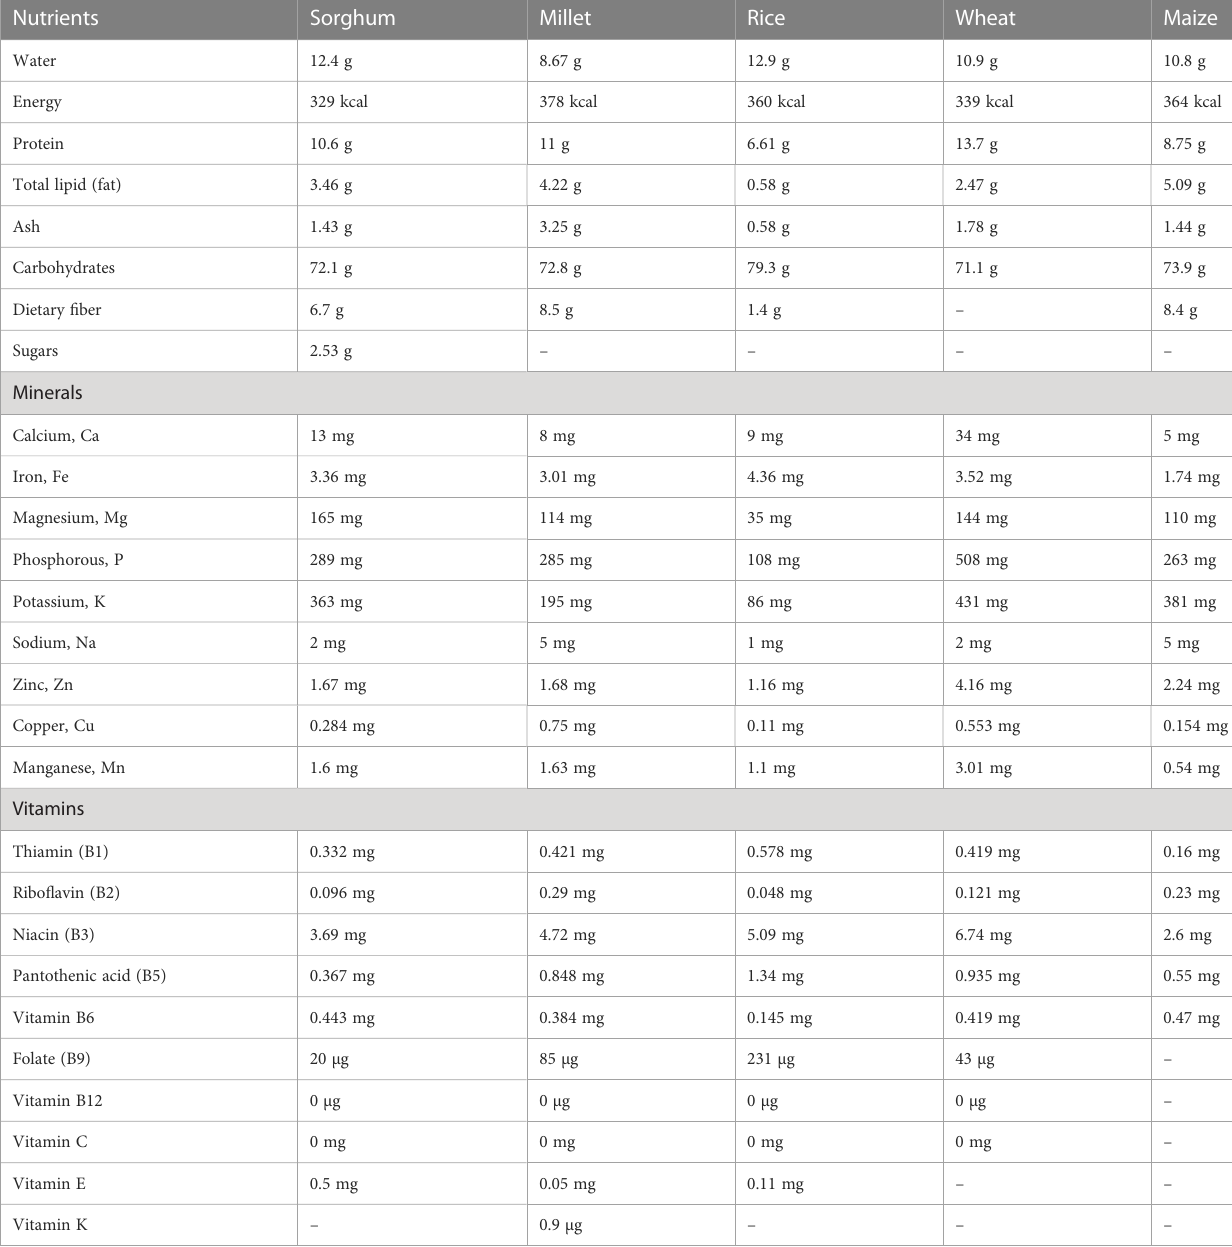
TABLE 1 Nutritional status of millet grains compared with other cereal crops (per 100 g).